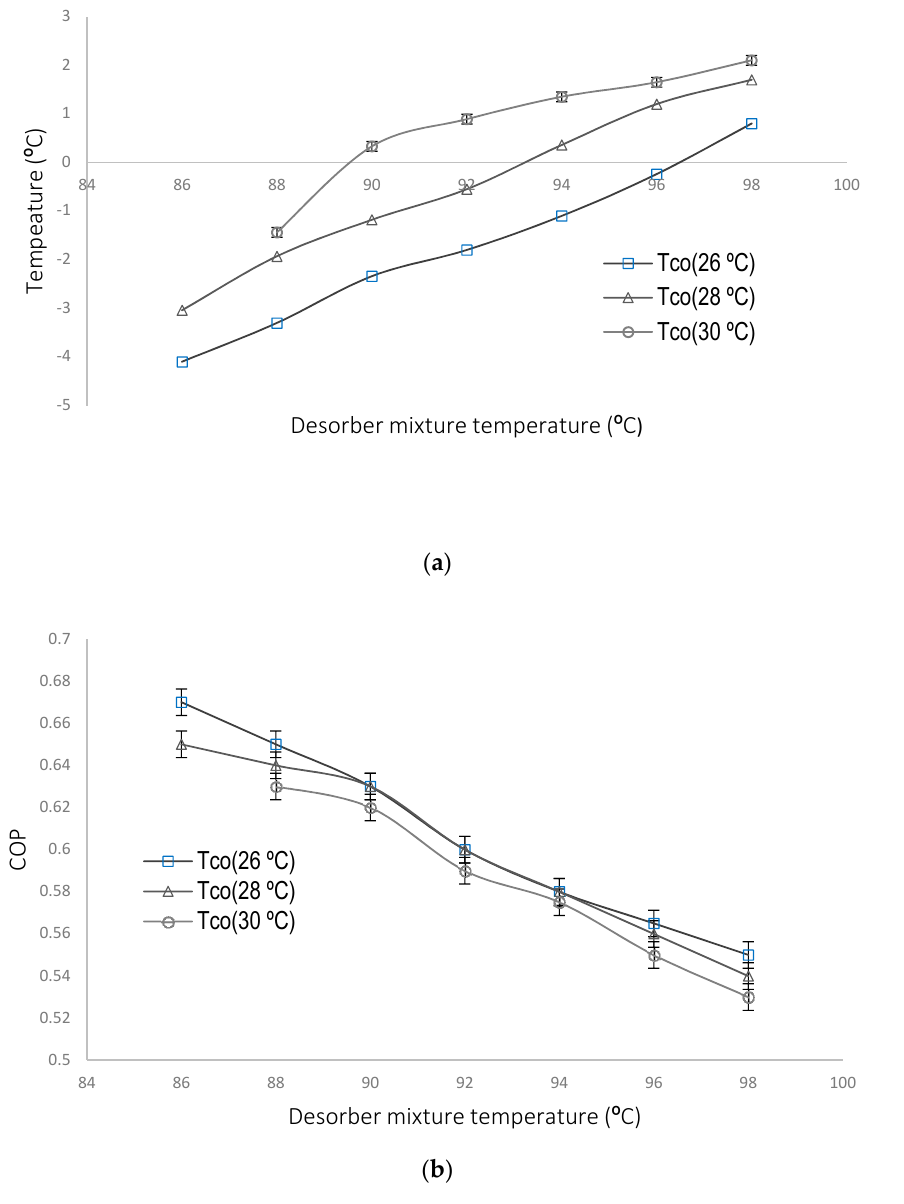
Figure 7. ( a ) Evaporator temperatures by heating solution temperatures at different TCO and internal heating solution temperatures at different TCO. ( b ) COP versus heating solution temperatures at different